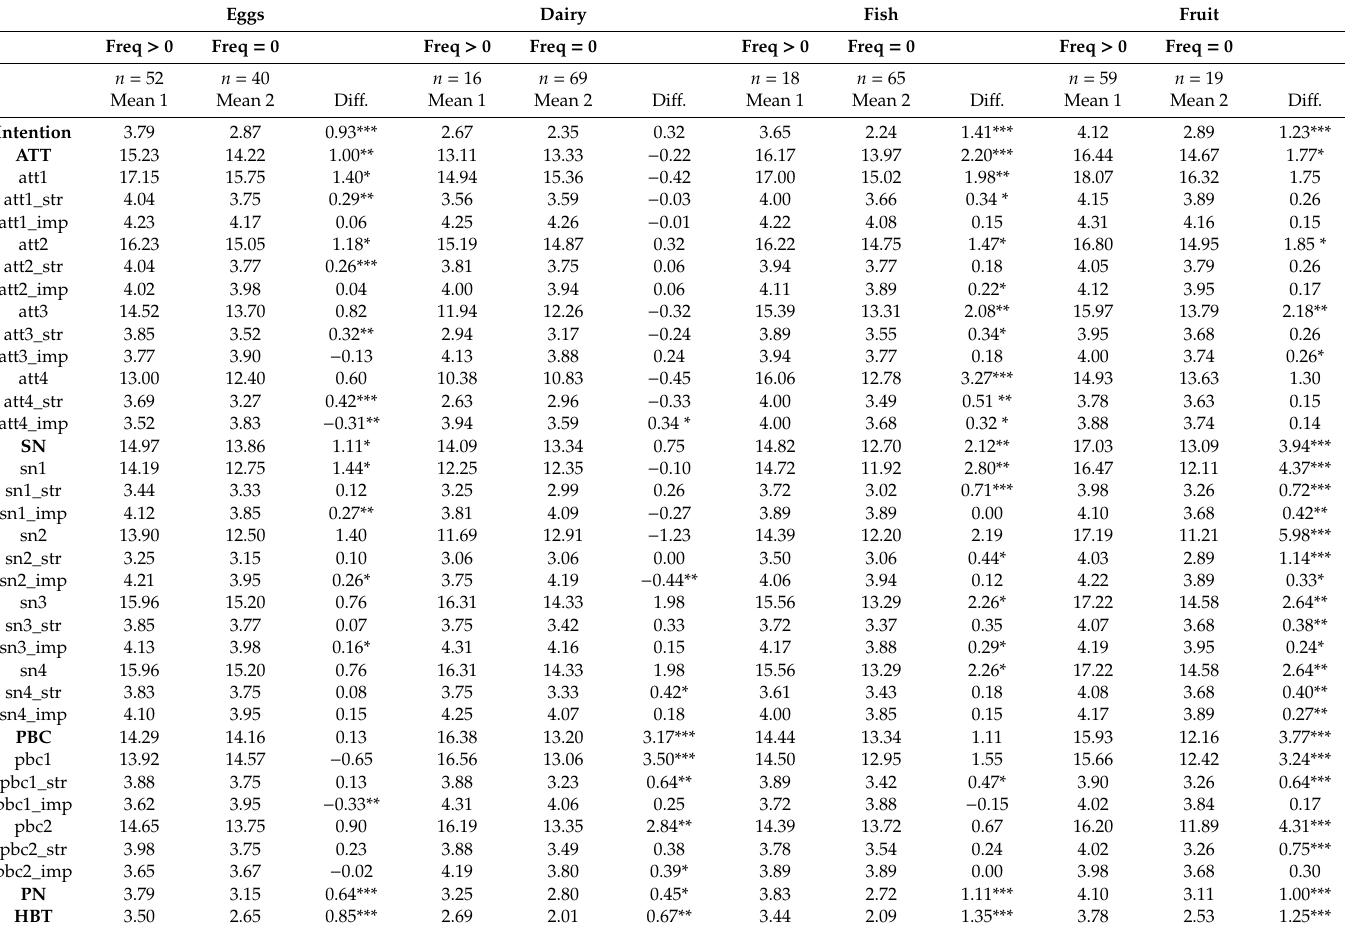
Table 3. Di ff erences in belief strength and importance evaluation by consumption frequency